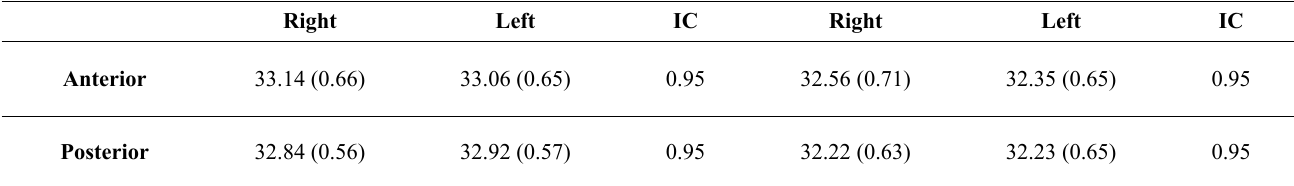
Figure 2 shown histogram of frequency distribution of the No significance difference was found between left and right averaged skin temperatures in the thigh and leg in anterior and sides from both anterior and posterior measurements of thighs posterior views with temperature range values about 29.0 – 33.0 o C. and legs for mean (table 2) or maximal (table 3) skin temperature. Table 2: Maximal values of skin temperature ( o C) of thigh and leg soccer players and theirs ICC’s Right Left IC Right Left IC Anterior 33.14 (0.66) 33.06 (0.65) 0.95 32.56 (0.71) 32.35 (0.65) 0.95 Posterior 32.84 (0.56) 32.92 (0.57) 0.95 32.22 (0.63) 32.23 (0.65)